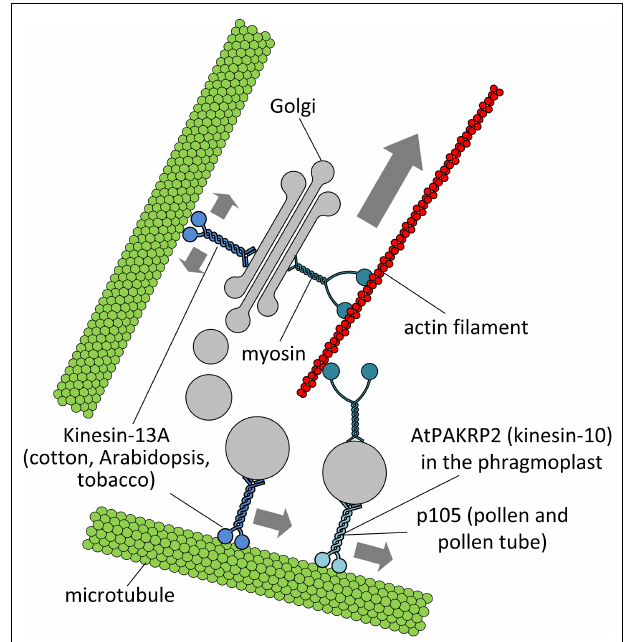
FIGURE 2 | Putative interactions between Golgi stacks/vesicles and motor proteins. Specific subclasses of myosin XI would be responsible for the long-range transport of Golgi bodies within plant cells. Members of the kinesin superfamily are likely involved in either the anchorage of Golgi stacks to microtubules (such as kinesin-13A) or the short-range transport of Golgi vesicles to defined cell positions (such as AtPAKRP2 and p105).The arrow length indicates the relative velocity as produced by motor proteins. Opposing arrows indicate an anchorage role for the motor.